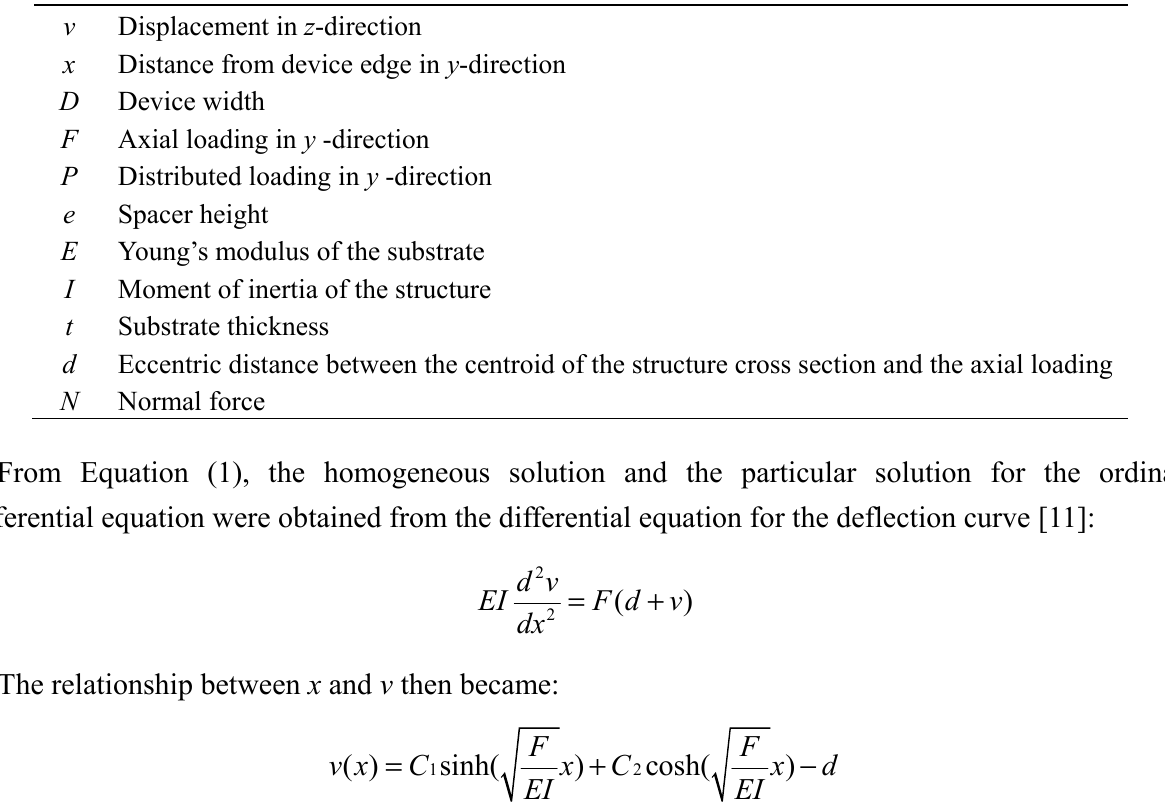
Table 1. Parameters used in this